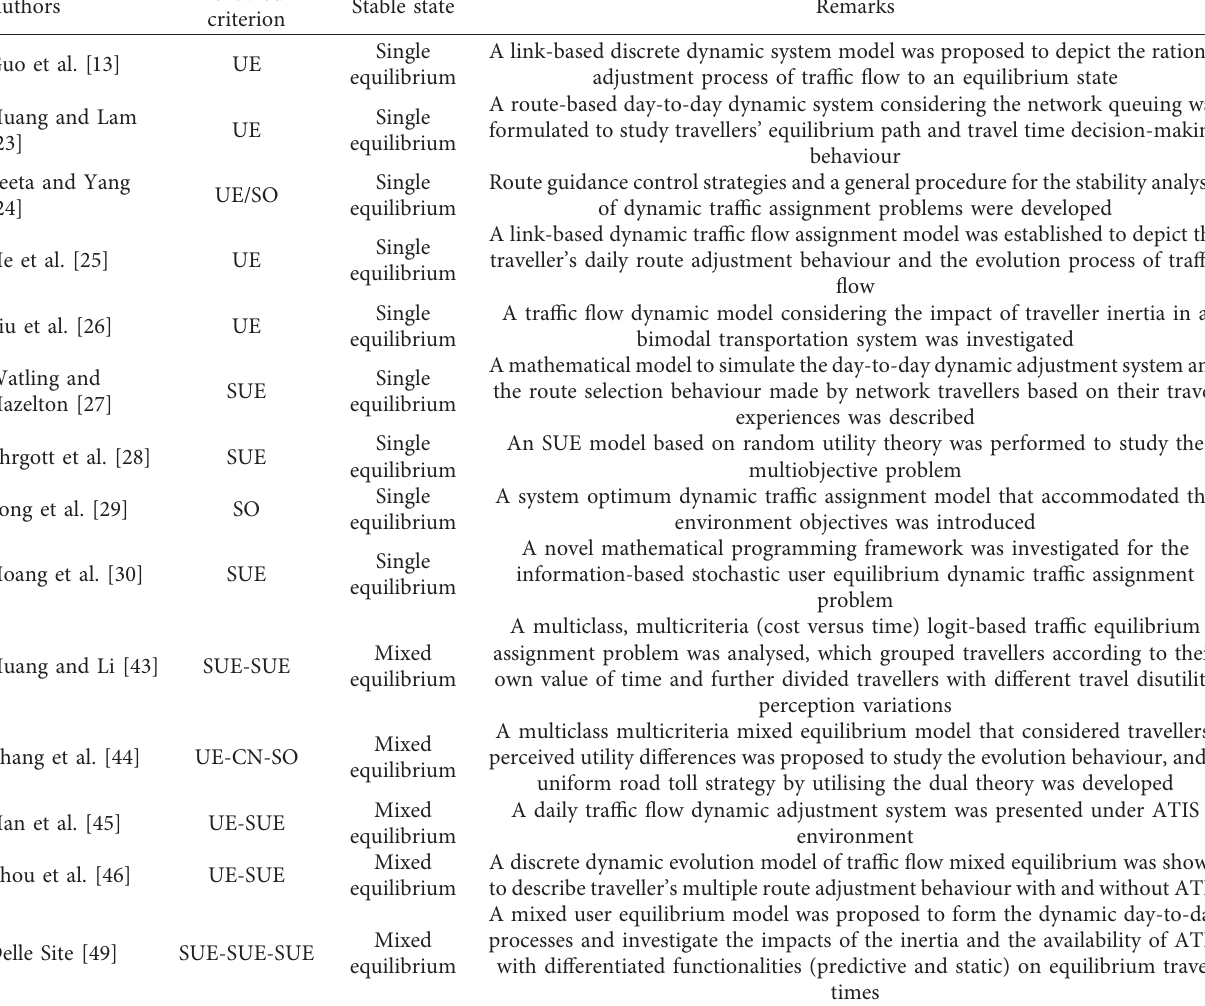
Table 1: Typical day-to-day flow dynamic